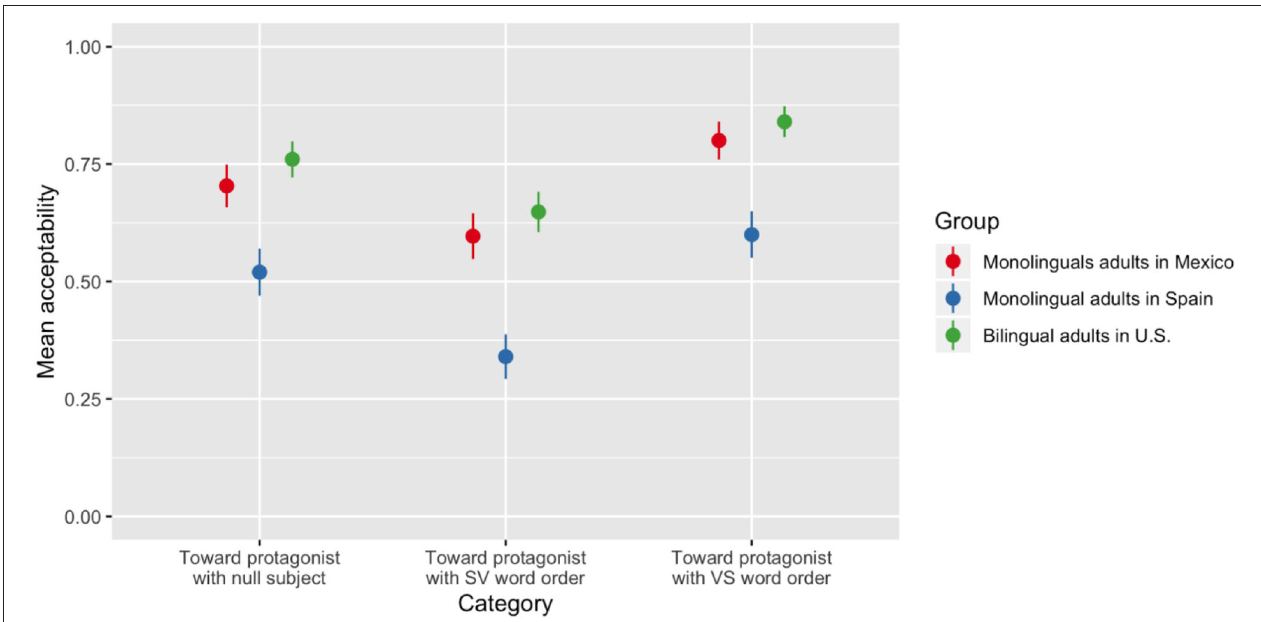
FIGURE 2 | Percentage of acceptability of items in the target categories by